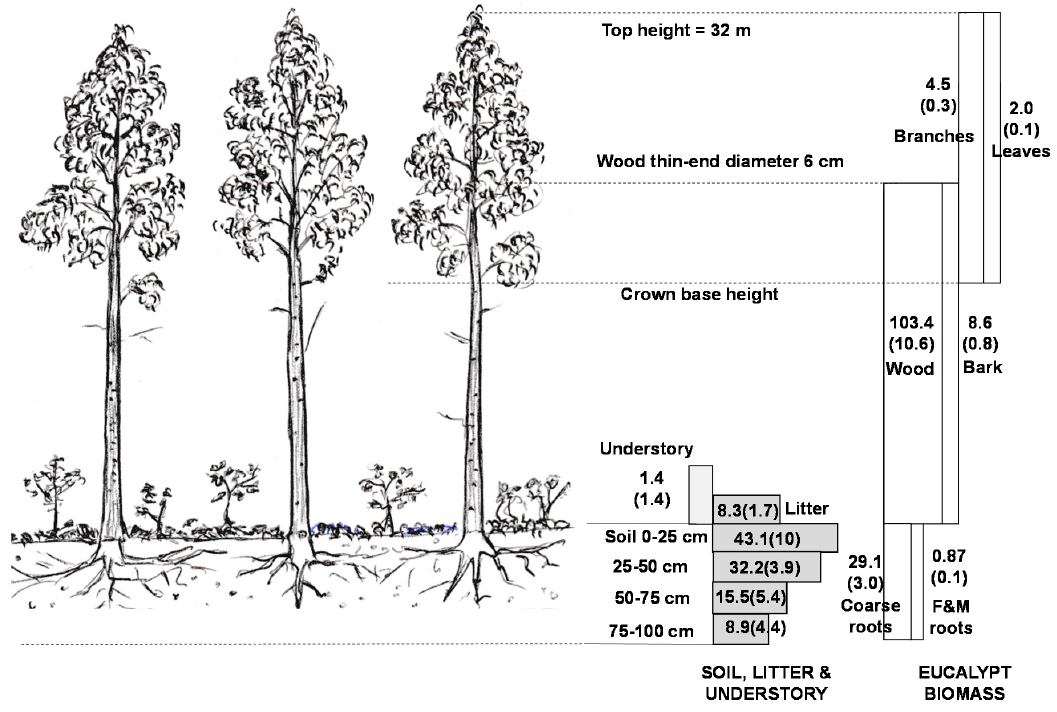
Figure 2. Illustrative carbon stock distributions (Mg ha − 1 ) in the 10-year-old Eucalyptus urophylla × Eucalyptus globulus stand. F&M roots = Fine + Medium roots (Prepared by the authors).